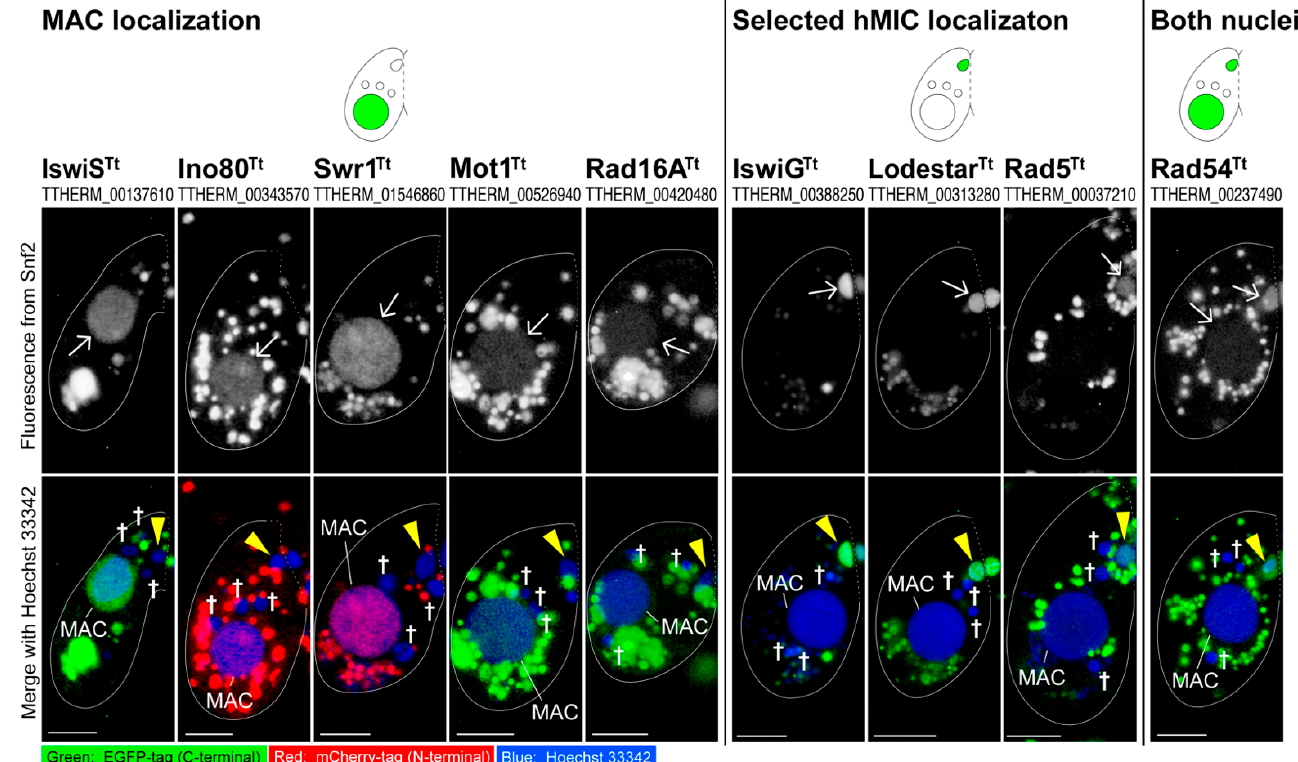
Figure 2. Subcellular localization of Tetrahymena Snf2 family fluorescent tagged proteins when the selected hMIC appeared. Arrow-fluorescent signal from EGFP/mCherry-tagged Snf2 family protein. The fluorescence signals scattered in the cytoplasm are likely the background derived from the fluorescent-tagged Snf2 family proteins undergoing degradation by turnover; triangle—the selected hMIC; †—unselected hMIC; the scale bar denotes 10 μ m.